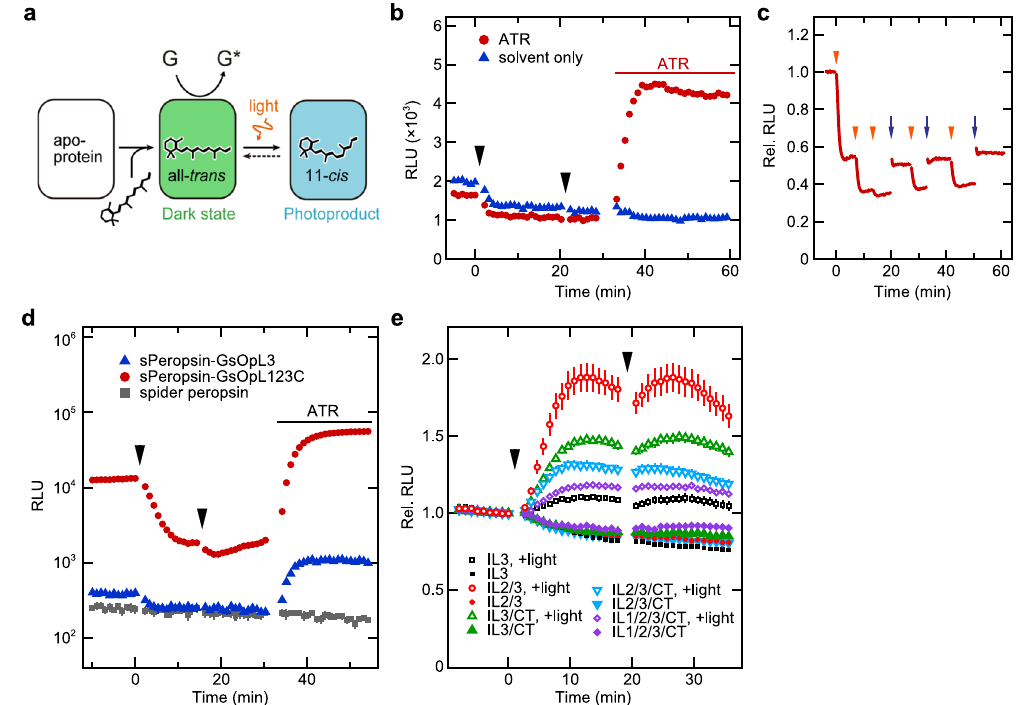
Figure 4. Peropsin mutant proteins serving as dark-active, light-inactivated GPCRs. ( a ) A schematic model for G protein activation by peropsin mutants. Apo-protein binds to all- trans -retinal and forms the dark state that activates G proteins. The dark state photo-converts to the photoproduct, or 11- cis -retinal-binding form, which does not efficiently activate G proteins. ( b ) GloSensor cAMP assay with sPeropsin-GsOpL3-expressing cells with addition of all- trans -retinal (ATR). All- trans -retinal (10 μ M) or only solvent (ethanol) was added. ( c ) GloSensor cAMP assay with sPeropsin-GsOpL3-expressing cells preincubated with all- trans -retinal. Cells were illuminated with amber (arrowheads) and blue (arrows) light. ( d , e ) GloSensor cAMP assay with cells expressing different peropsin mutants that activate Gs ( d ) and Gi ( e ). ATR, all- trans -retinal (10 μ M). Basal cAMP level was elevated by adding forskolin (1 μ M) before the measurements ( e ). Averaged values for three samples are shown with error bars (s.e.m.) ( b , d , e) . Cells were illuminated with amber light (arrowheads; b , d , e